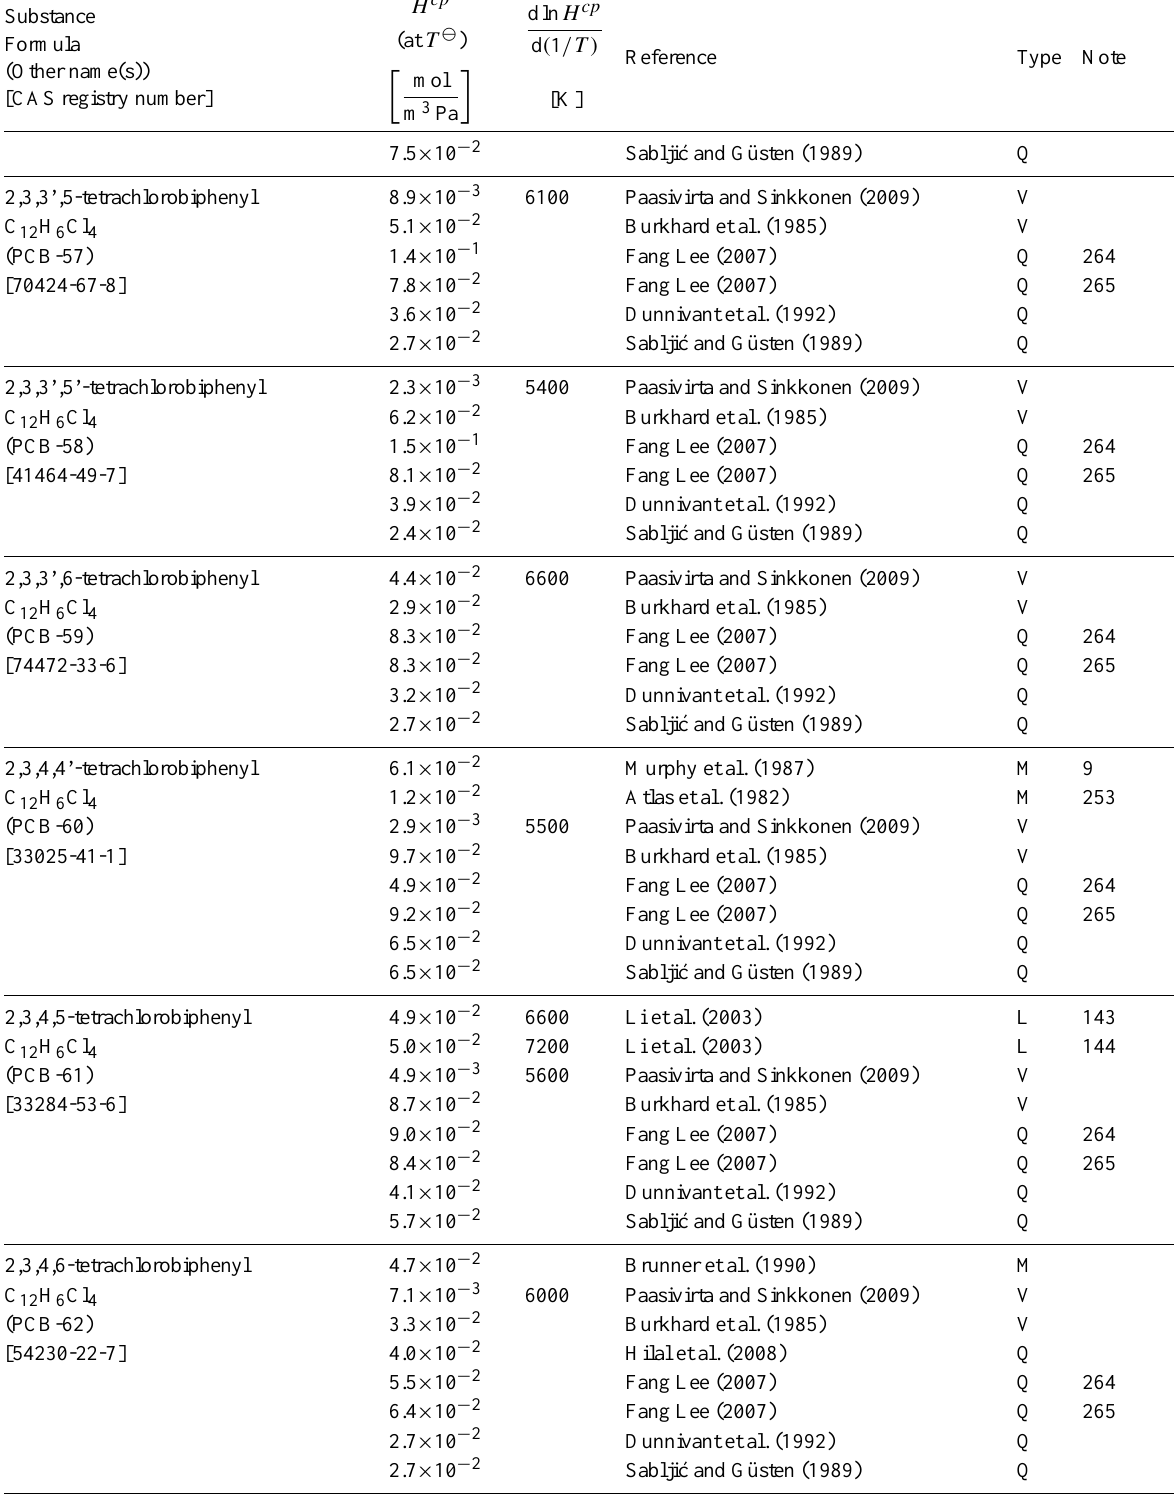
Table 6: Henry’s law constants for water as solvent